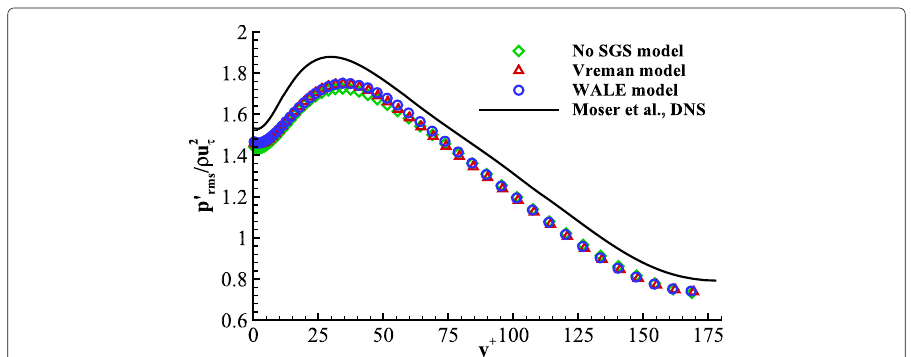
Fig. 5 The r.m.s. pressure fluctuations for the fully developed turbulent channel flow